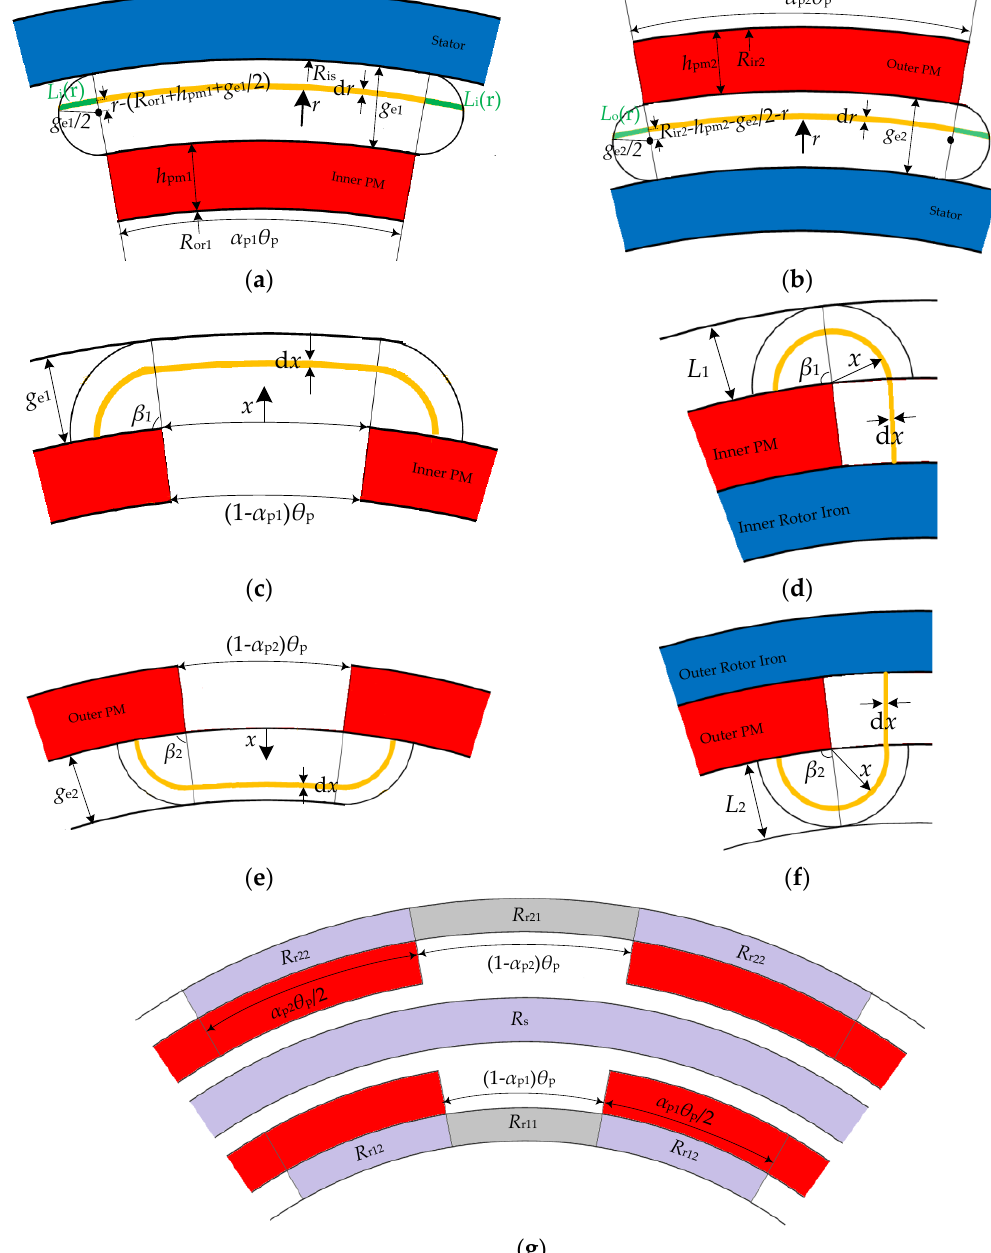
Figure 3. The flux path for calculating: ( a ) The effective inner air gap reluctance; ( b ) The effective outer air gap reluctance; ( c ) The inner magnet to magnet leakage reluctance; ( d ) The inner magnet to inner rotor iron leakage reluctance; ( e ) The outer magnet to magnet leakage permeance; ( f ) The outer magnet to iron leakage reluctance; ( g ) The rotor yokes reluctances.